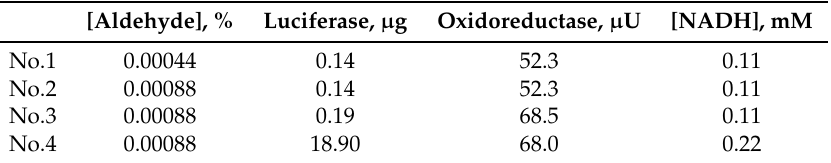
Table 1. Concentrations of enzymes and their substrates in microfluidic chips.